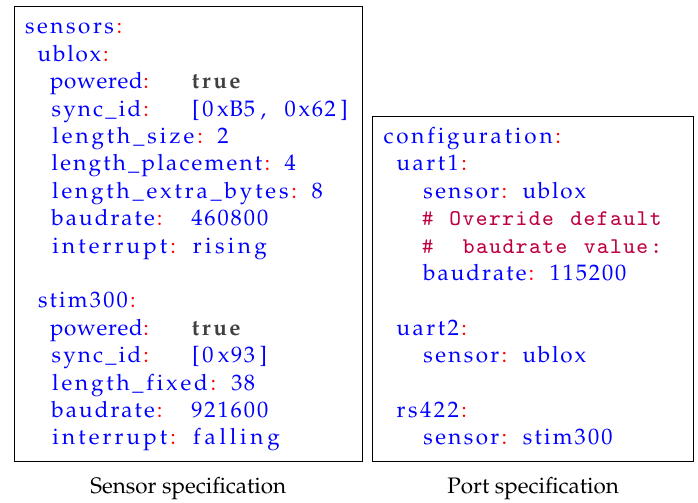
Figure 8. An example of text files for sensor port configuration, written in YAML.